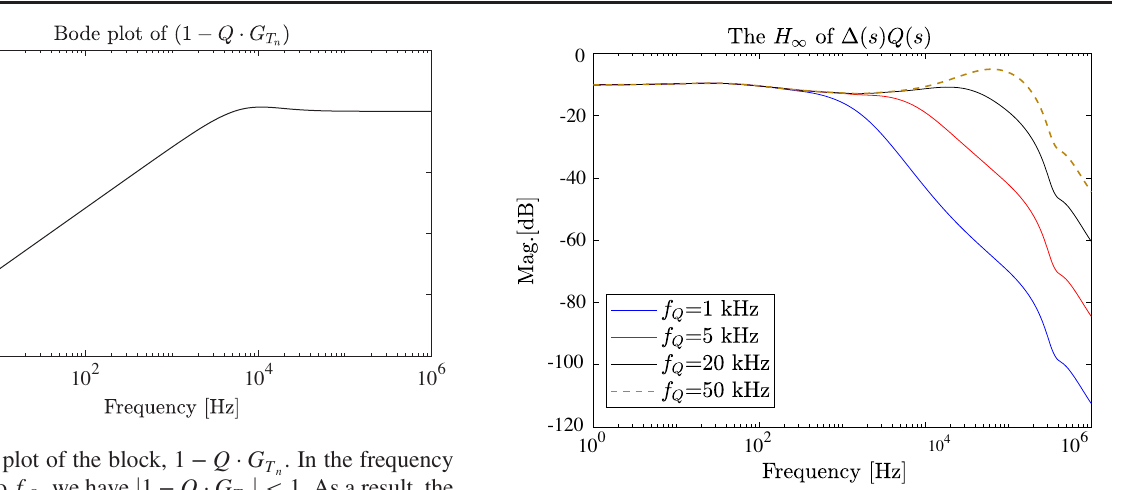
FIG. 15. Bode plot of the block, 1 − Q · G T range from DC to f Q , we have j 1 − Q · G T closed-loop system response from d to y will be improved by the DOB